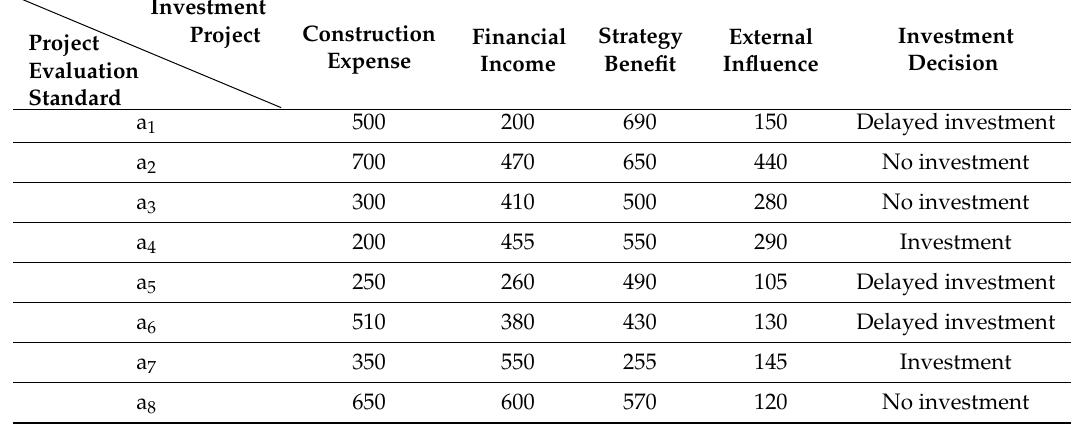
Table 1. Knowledge expressing system of investment decisions. Unit: RMB